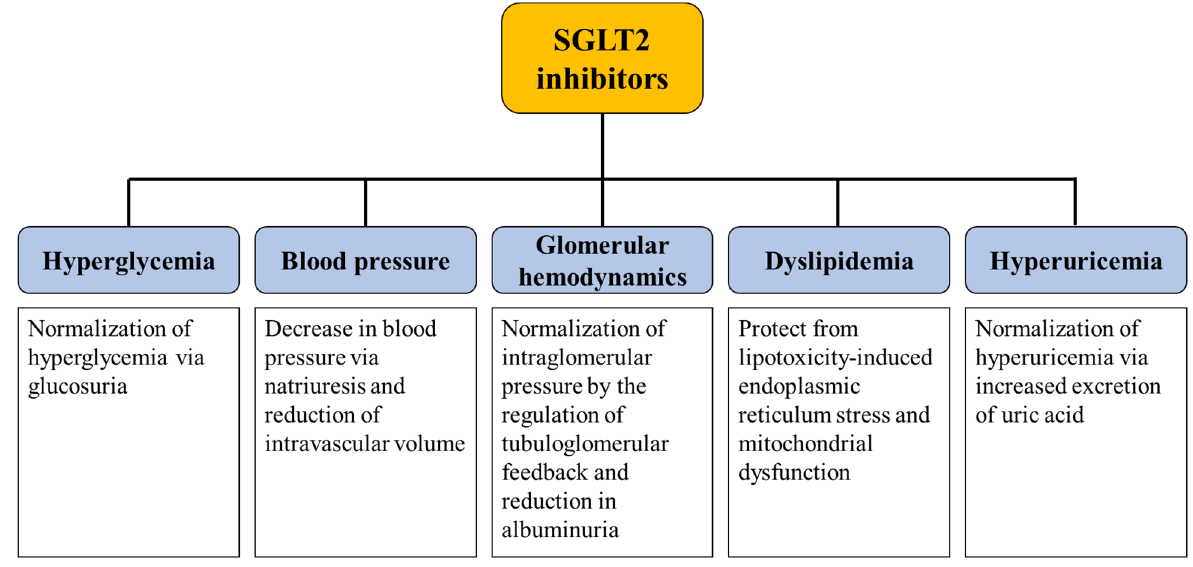
Figure 1. Summary of the potential mechanisms underlying the renoprotective effect of SGLT2 inhibitors. SGLT2 inhibitors potentially protect the progression of diabetic kidney disease through pleiotropic effects. SGLT2; sodium-glucose cotransporter-2.